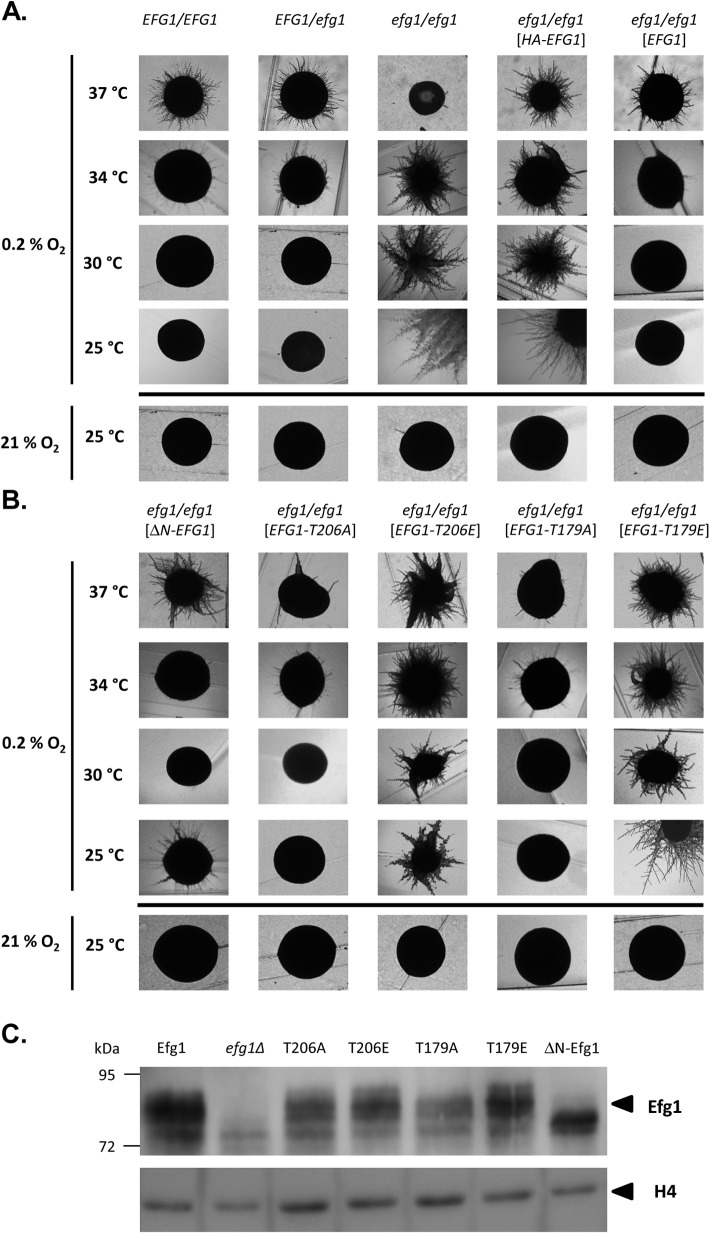
Hypoxia and temperature dependent filamentation regulated by Efg1 variants.(A, B) Colony phenotypes. Strains were grown under hypoxia (0.2% O2) on the surface of YPS agar at 37°C (3 d), 34°C (3 d), 30°C (3 d) or 25°C (4 d) and under normoxia (21% O2) at 25°C (4 d). (C) Efg1 immunoblot. Strains werμe grown on YPS agar for 60 h at 25°C before cell harvesting by scraping off the colonies. 75 μg of protein in cell extracts were separated by SDS-PAGE (8% acrylamide) and immunoblots were developed using anti-Efg1 antiserum. Levels of histone H4 (loading control) were detected by anti-histone H4 antibodies. Strains tested were CAF2-1 (EFG1/EFG1), BCA0901 (EFG1/efg1), HLC52 (efg1/efg1), HLCEEFG1 (efg1/efg1 [HA-EFG1]), HLCPEFG1 (efg1/efg1 [EFG1]), HLCNEFG1 (efg1/efg1 [ΔN-EFG1]), HLCEEFG1T206A (efg1/efg1 [EFG1-T206A]), HLCEEFG1T206E (efg1/efg1 [EFG1-T206E]), HLCEEFG1T179A (efg1/efg1 [EFG1-T179A]) and HLCEEFG1T179E (efg1/efg1 [EFG1-T79E]).